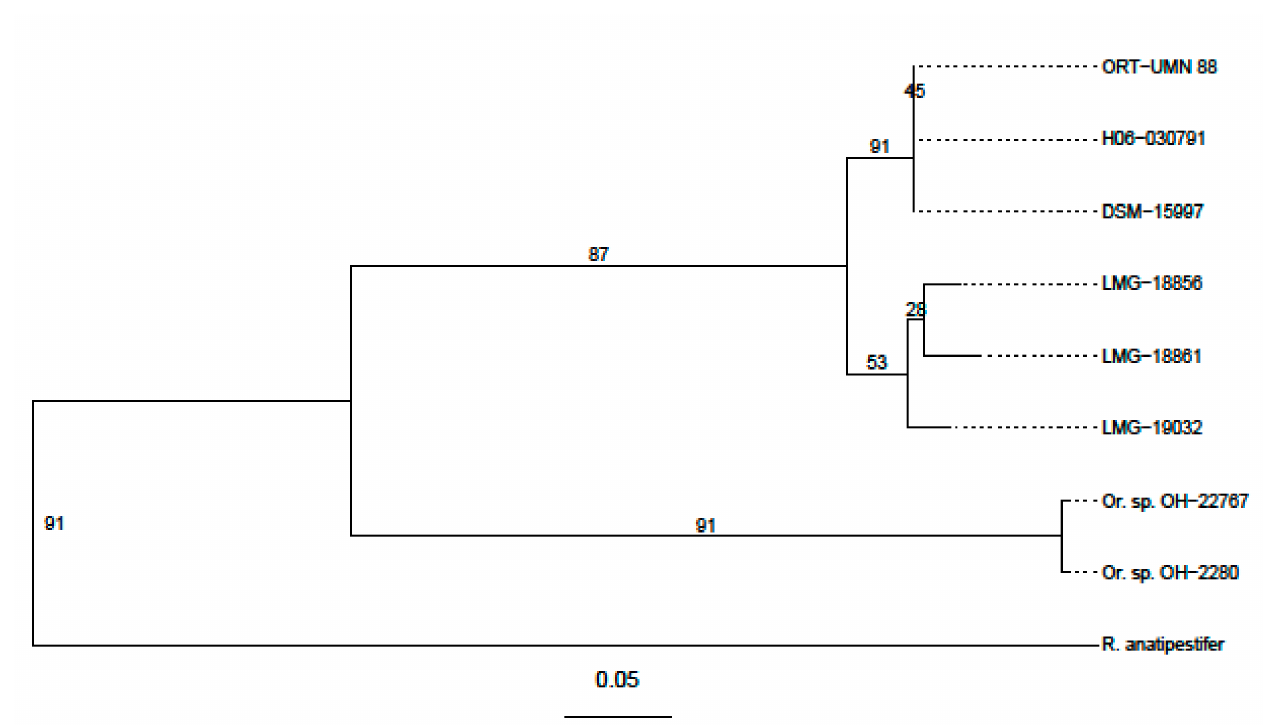
Figure 4. UBCG maximum likelihood multi-gene tree of the sequenced O. rhinotracheale and Cand. O hominis ( O. sp. OH-22767 & OH-2280 ) strains using Riemerella anatipestifer (DSM 15868) as an outgroup. The tree was constructed RAxML with a general time-reversible model with gamma-distributed rate variation and 1000 bootstraps. The numbers display the gene support index (gsi), indicating how many of the gene trees support each split of the final concatenated tree. The gene encoding tig (Trigger factor) was not identified in any genome, so in the end, only 91 core genes were